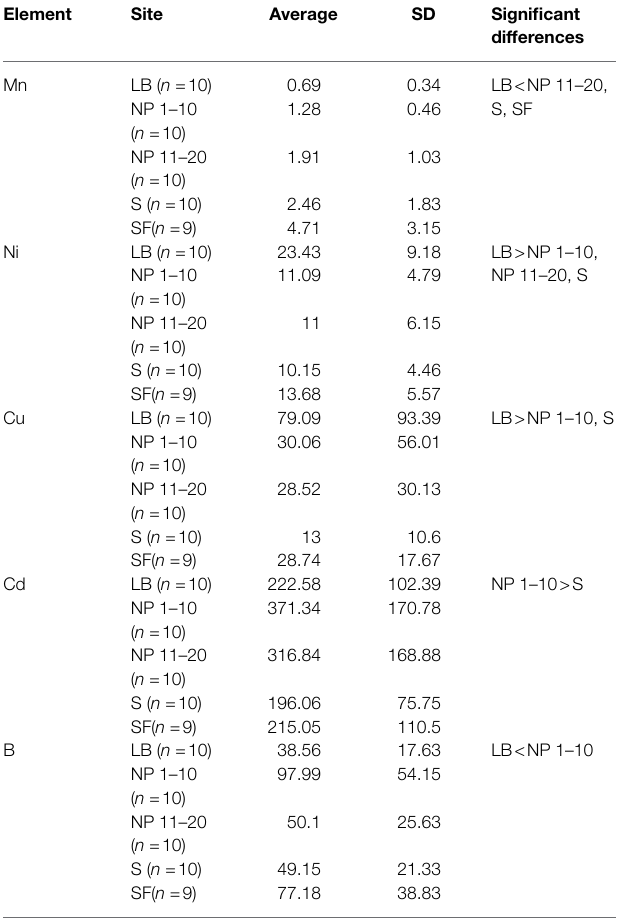
( Supplementary Table S5 ): Cu and Ni pointed to the LB